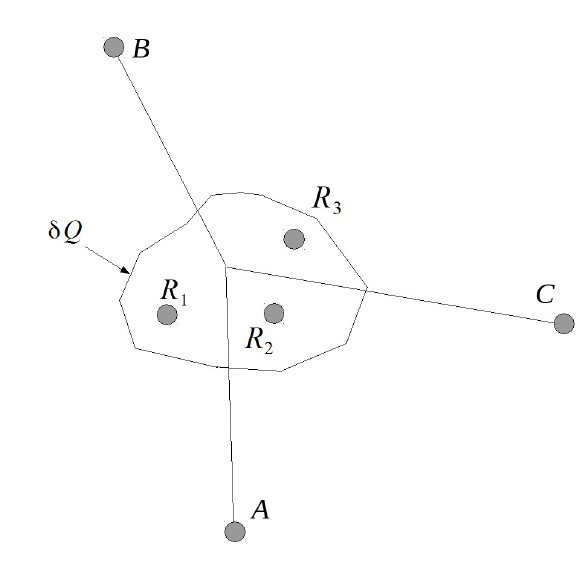
Figure 3: Example of tessellation for three